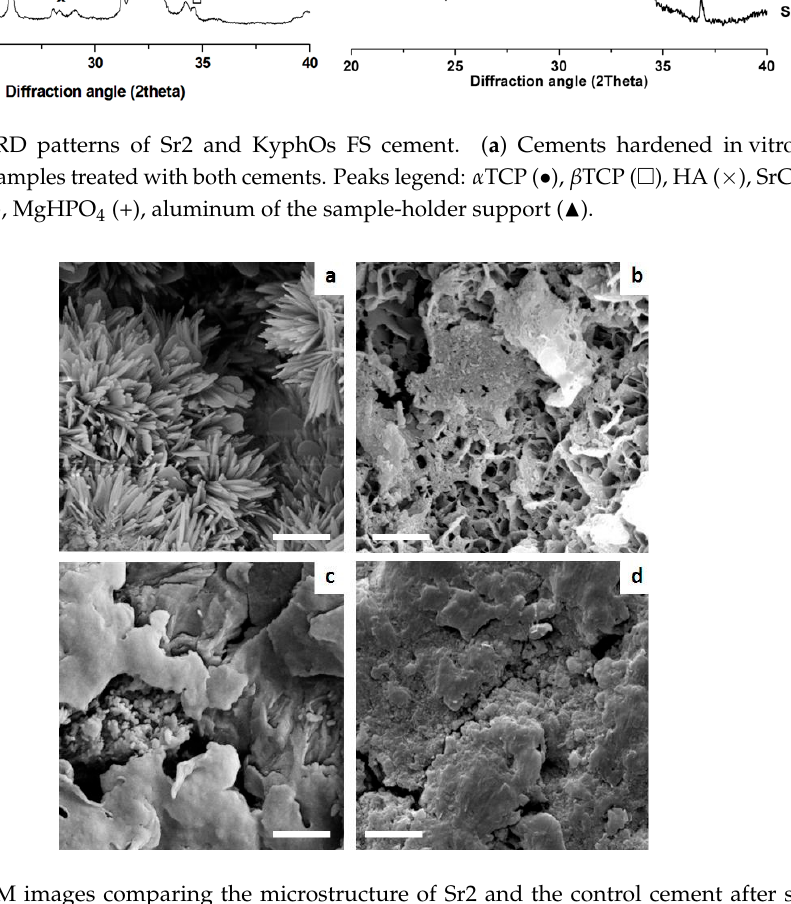
Figure 12. SEM images comparing the microstructure of Sr2 and the control cement after setting in vitro and in vivo. ( a ) Sr2 in vitro; ( b ) Sr2 in vivo; ( c ) KyphOs in vitro; and ( d ) KyphOs in vivo. Scale bars = 1 µm.